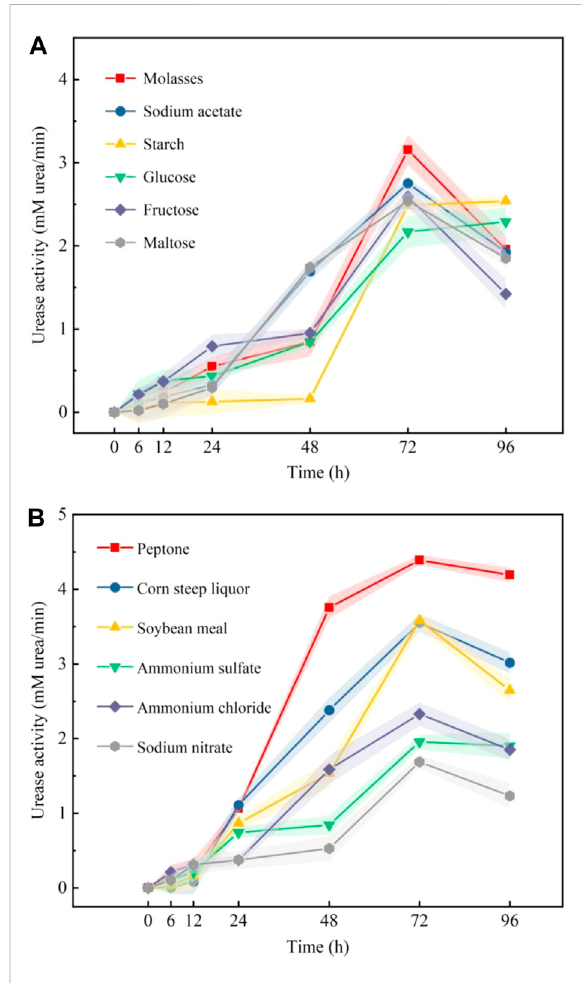
FIGURE 5 Effect of different carbon sources (A) and nitrogen sources (B) on the urease activity of